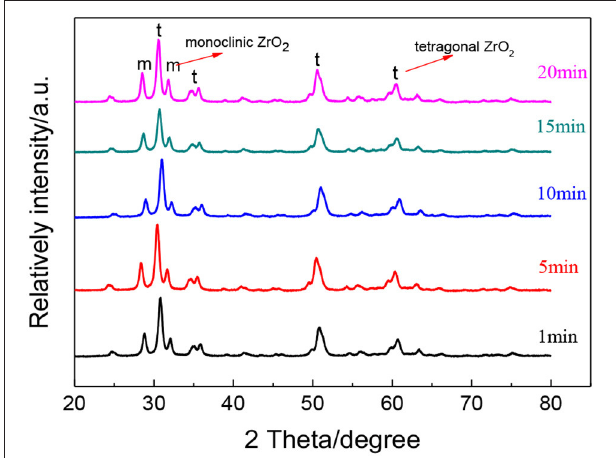
FIGURE 7 | XRD patterns of ZrO 2 materials synthesized with different ultrasonic radiation times at an ultrasonic power of 90% and when the molar ratio of precursor to precipitant is 1:1.